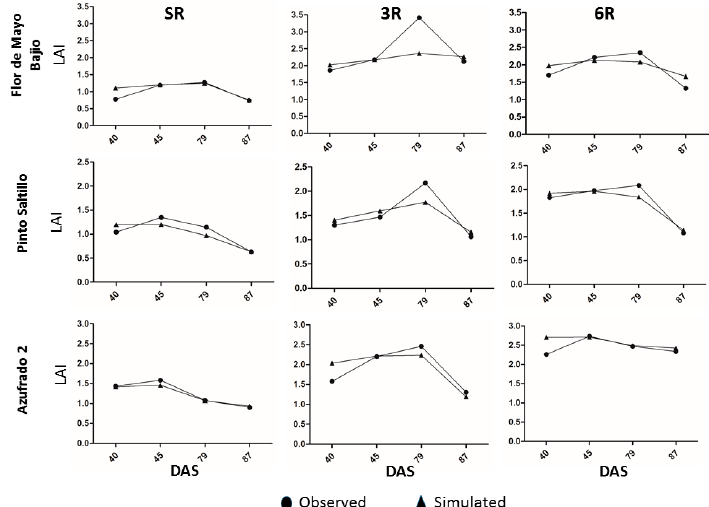
Figure 1. Observed and simulated leaf area index (LAI) of common bean cultivars growth habit III Flor de Mayo Bajio and Pinto Saltillo and growth habit I Azufrado 2 at different days after sowing (DAS) at seed densities of 90,000 (single rows, SR), 145,000 (three rows, 3R), and 260,000 (six rows, 6R) plants ha − 1 under rainfed conditions in Mexican highlands.